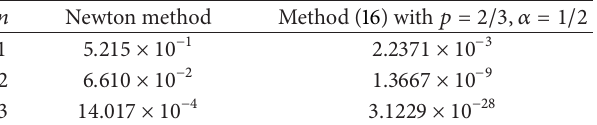
Table 1: Error computing results of